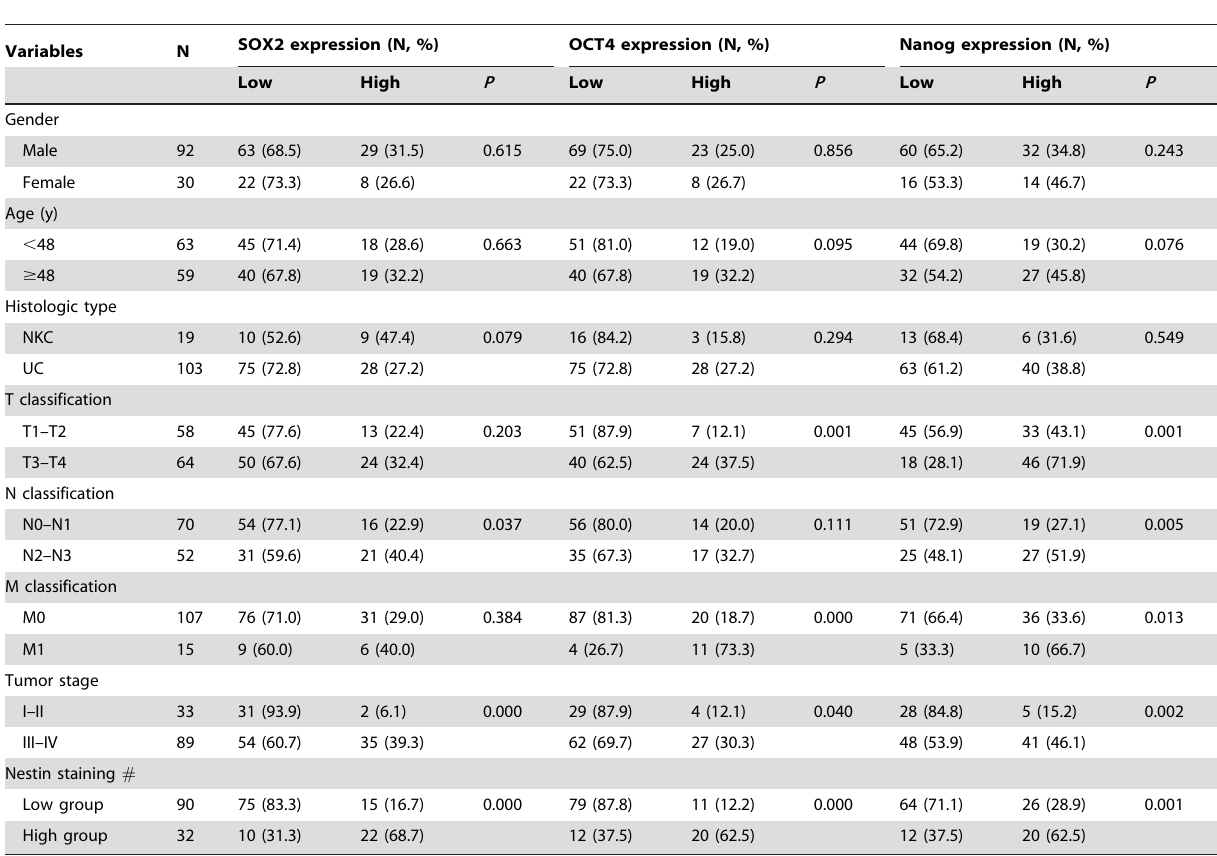
Table 2. Associations between the clinicopathologic factors and SOX2, OCT4 and Nanog at the tumor invasive front in 122 NPCs.